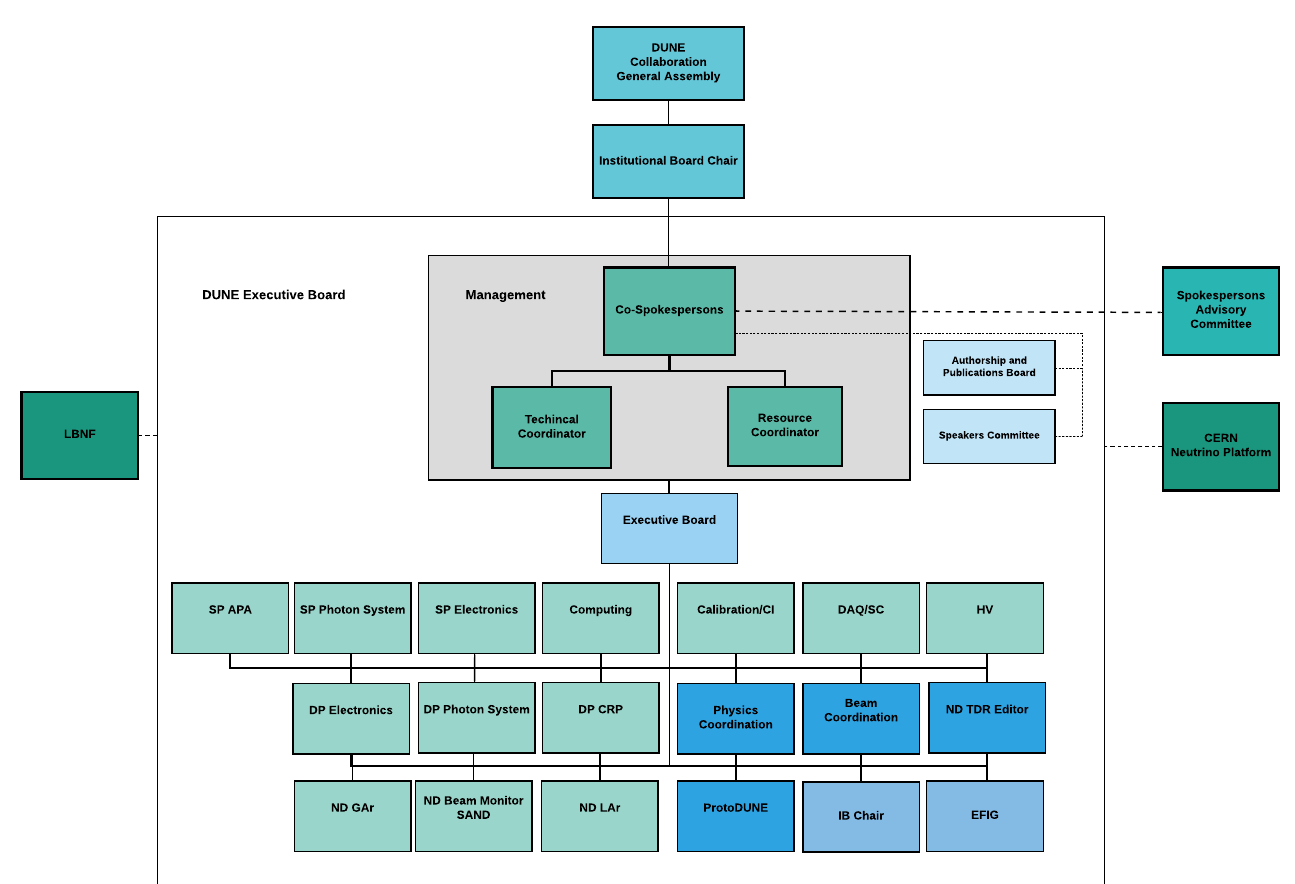
Figure 3. Organization chart of the DUNE ND management